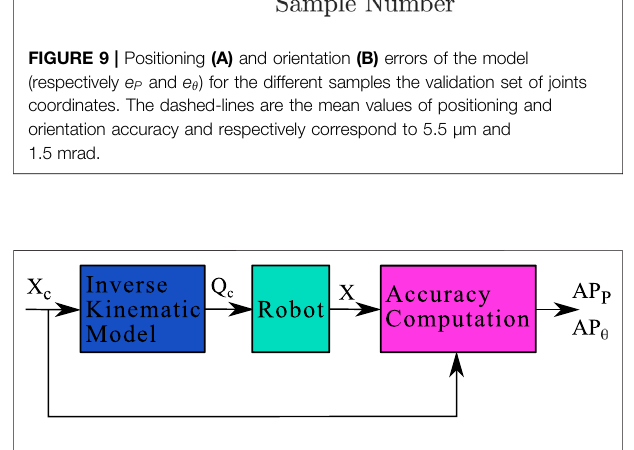
FIGURE10| Blockdiagramofthepositioncontroloftherobot using the Inverse Kinematic Model.